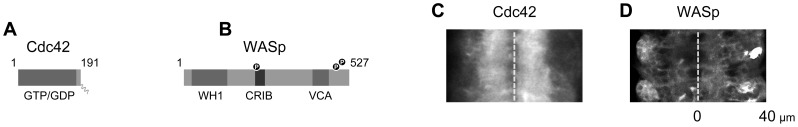
Cdc42 and WASp.A. Cdc42 becomes active when it replaces GDP with GTP. B. WASp receives phosphorylation and can associate with active Cdc42 through its CRIB domain. C Localization of Cdc42 (elav-GAL4/UAS-mCherry::Cdc42). D Localization of WASp2 (elav-GAL4/UAS-mCherry::WASp). Dashed line indicates midline in the CNS segment.